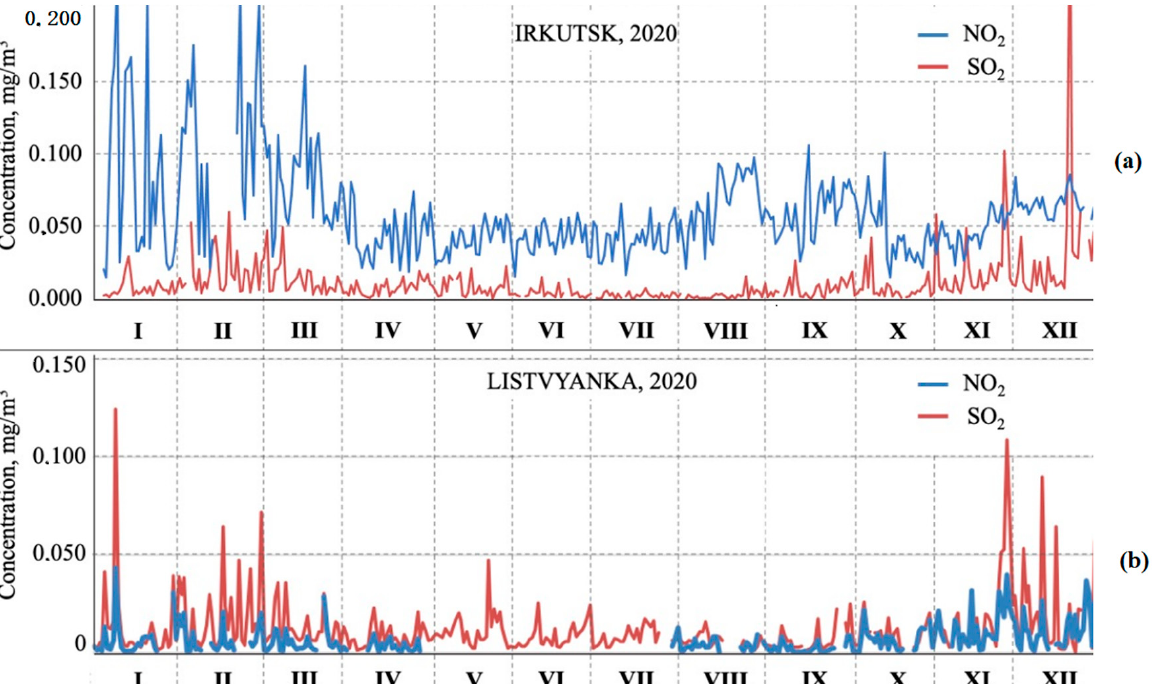
Figure 3. Average diurnal concentrations of SO 2 and NO 2 during 2020: ( a ) in Irkutsk (the Roshydromet data [8]) and ( b ) at the Listvyanka station (personal data).